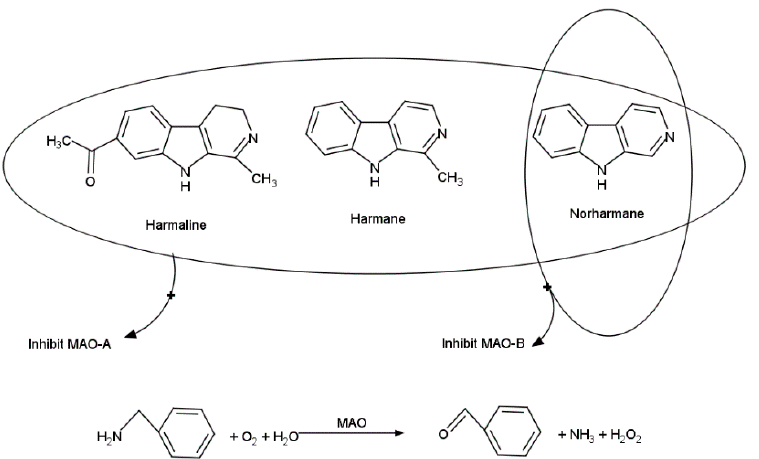
Figure 3. The detection of β -carbolines based on MAO-A global inhibition and discrimination of norharmane based on specific MAO-B inhibition.